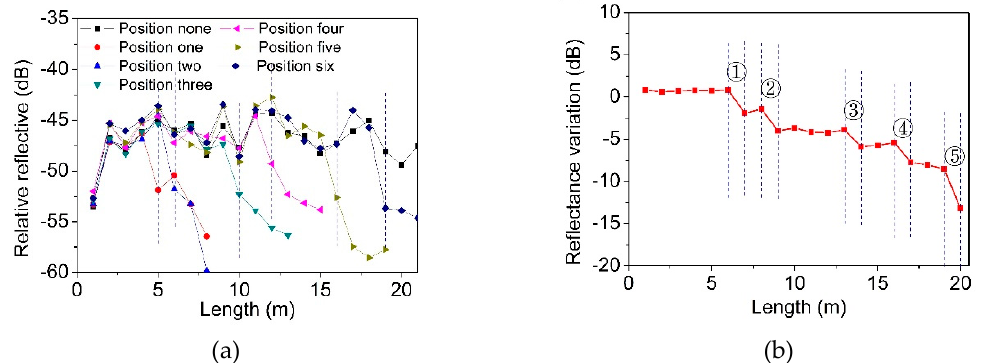
Figure 14. Variation of reflection peak intensity when the deformation is located in ( a ) a different area and ( b ) multiple areas.